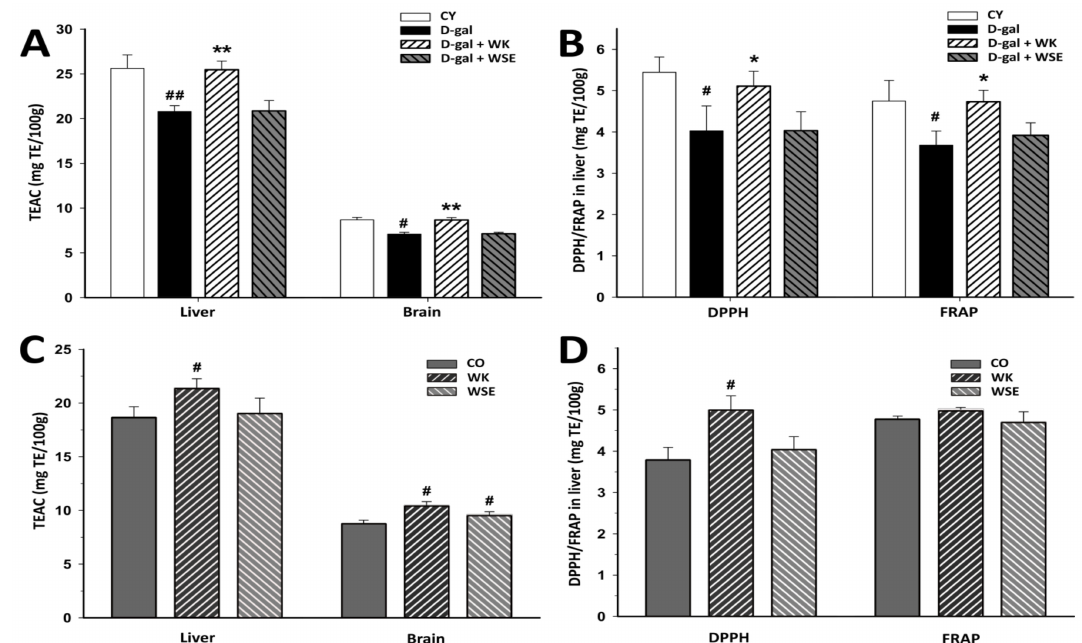
Figure 5. The e ff ects of walnut kernels (WK) and a walnut septum extract (WSE) on antioxidant activity (values expressed as mean ± SD; n = 5); # p < 0.05 and ## p < 0.01 compared to control; * p < 0.05 and ** p < 0.01 compared to D-gal group (CO—control old; CY—control young; D-gal—D-galactose). ( A